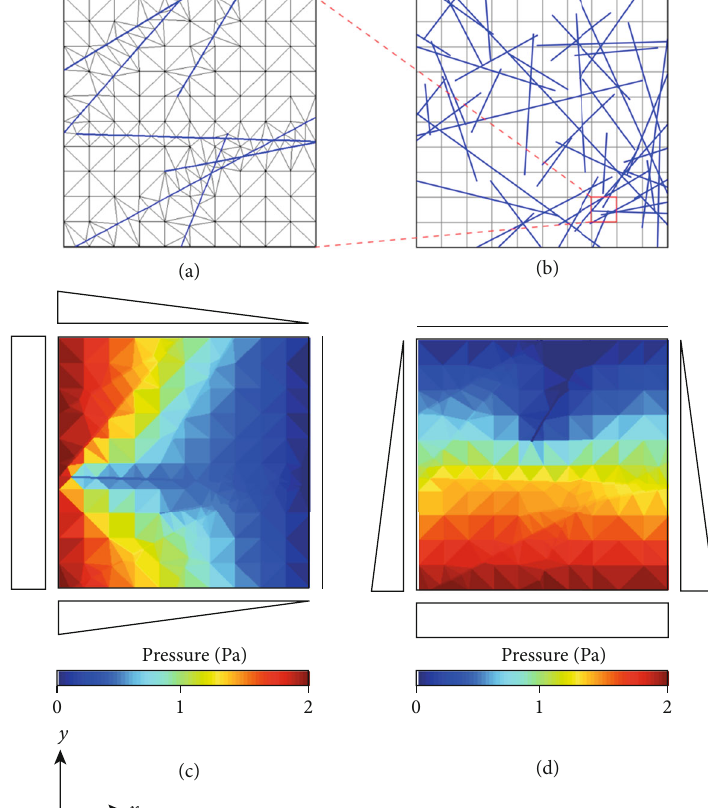
Figure 2: (a) Unstructured meshes of the discrete fracture model within the grid block. (b) Cartesian grid for the equivalent fracture model with l = 4m and N = 50 ; the corresponding solutions of the steady-state fl ow problems with the linear boundary conditions (c) along the x min -axis and (d) along the y -axis.